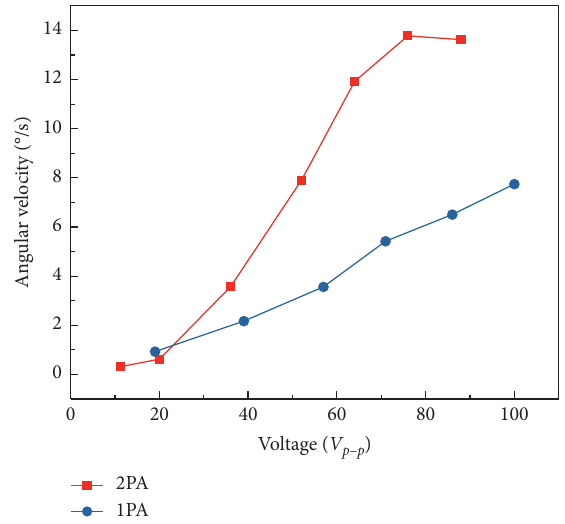
Figure 17: Driving by a sawtooth wave signal at 2000Hz under different